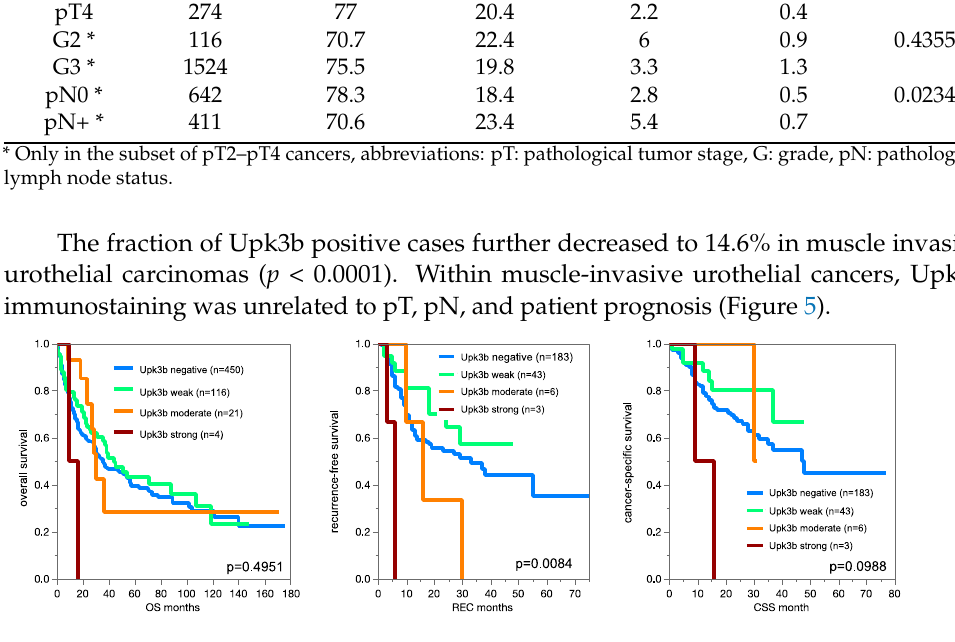
Figure 5. Impact of Upk3b immunostaining on overall survival, recurrence-free survival, and cancer specific survival in muscle-invasive urothelial carcinomas.